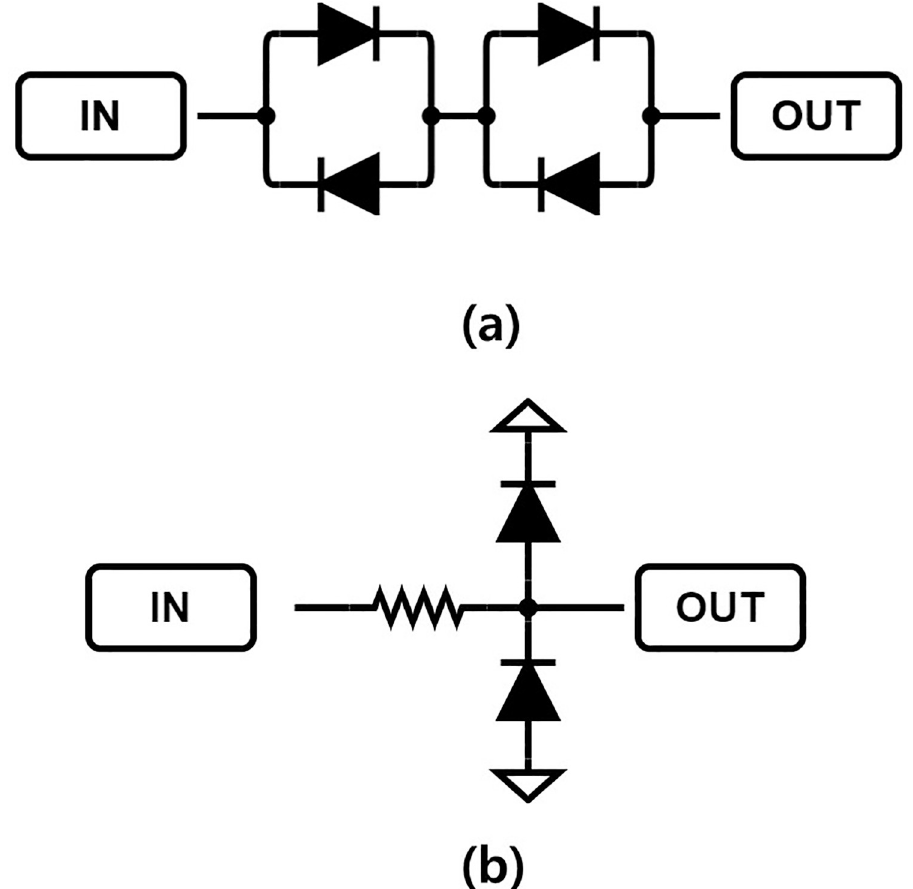
Fig 12. Limiter and expander schematic used in the experiment. (a) Expander (b) limiter circuits.